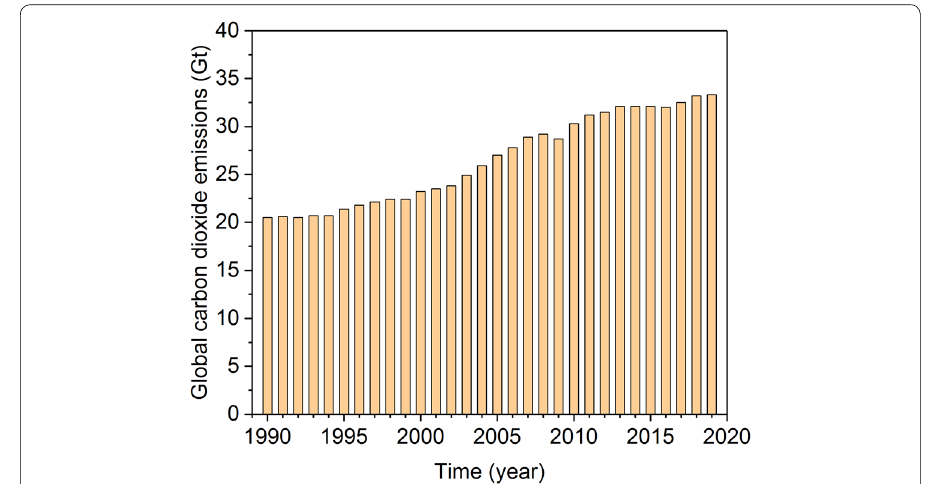
Fig. 2 Statistics of global energy-related CO 2